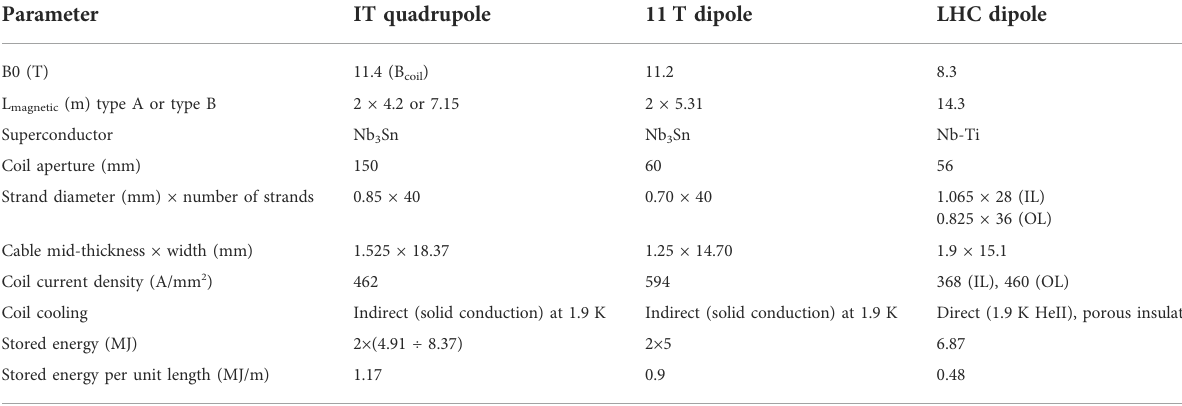
TABLE 1 Parameters of the HL-LHC IT quadrupoles and 11 T dipoles and the LHC main